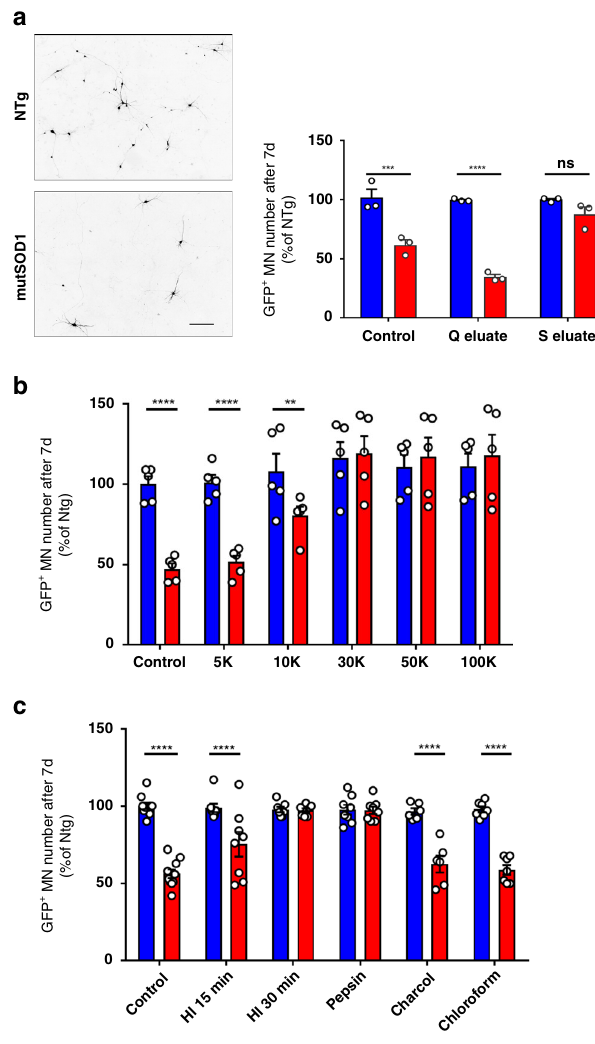
retentates from the 30-, 50-, and 100-kDa cutoff fi ltrations of mutSOD1 ACMs vs. NTg ACMs (Fig. 1b); similar results were obtained with molecular weight cutoff dialysis cassettes.